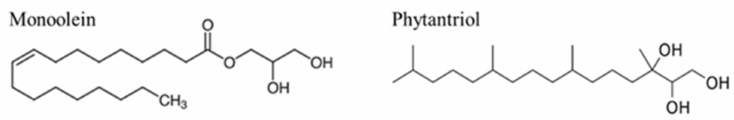
Figure 6. Chemical structure of monoolein and